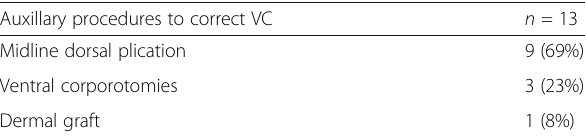
Table 7 Type of neourethral cover used after urethroplasty Type of neourethral cover used